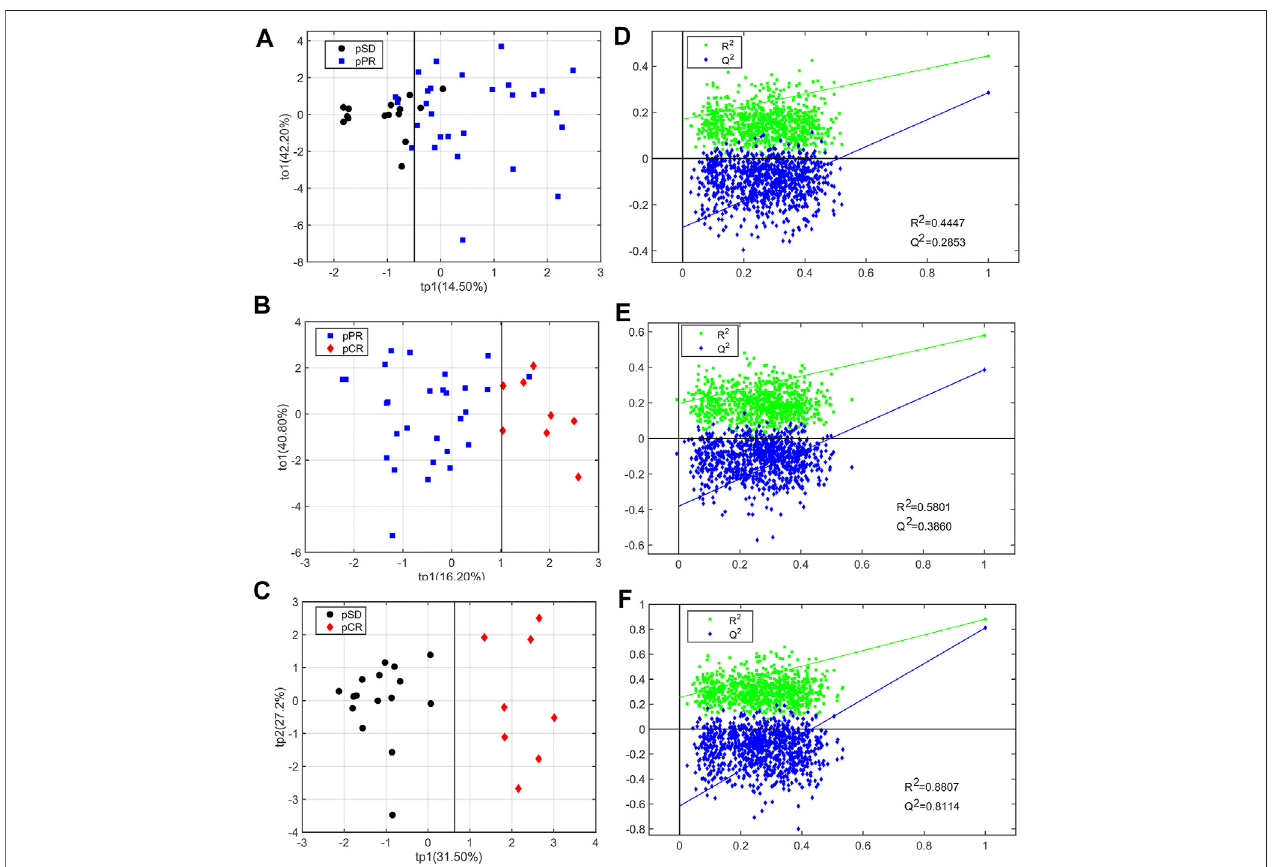
FIGURE 3 | OPLS-DA score plots and corresponding permutation tests of the relative concentration of metabolites ’ data from three groups of TNBC patients: (A, D )pSDpatientsvs.pPRpatients; (B,E) pSDpatientsvs.pCRpatients; (C,F) pPRpatientsvs.pCRpatients.IntheRPTplots,thegreensquareisR 2 (cum),denotingthe explained variance of the model. The blue diamond is Q 2 (cum), standing for the predictive ability of the